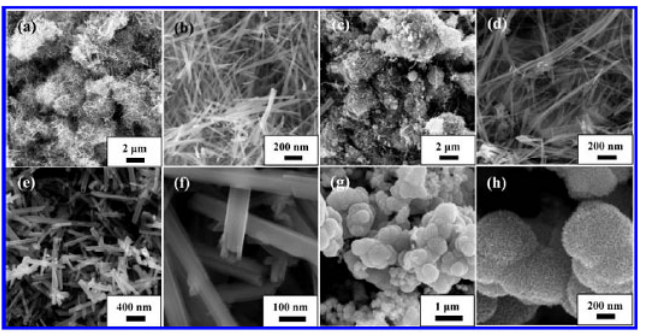
Figure 13. Mechanism of toluene oxidation on α‐ MnO 2 . Reprinted with permission from Ref. [99]. Copyright 2021 Elsevier.